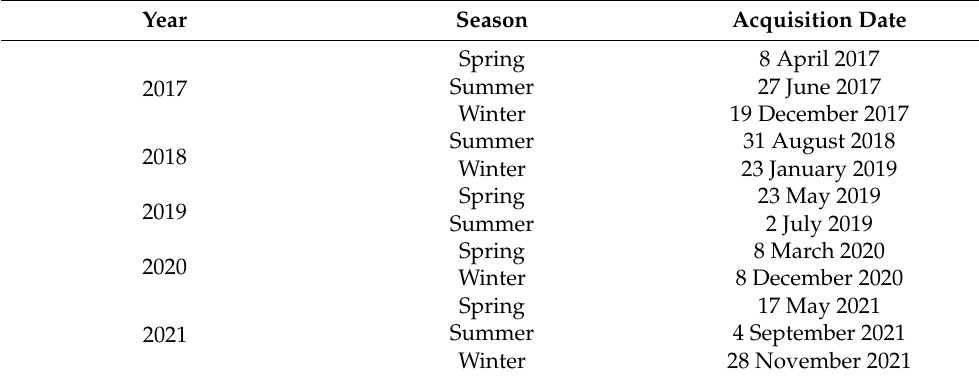
Table 6. The acquisition time of 12 Sentinel-2 images from 2017 to